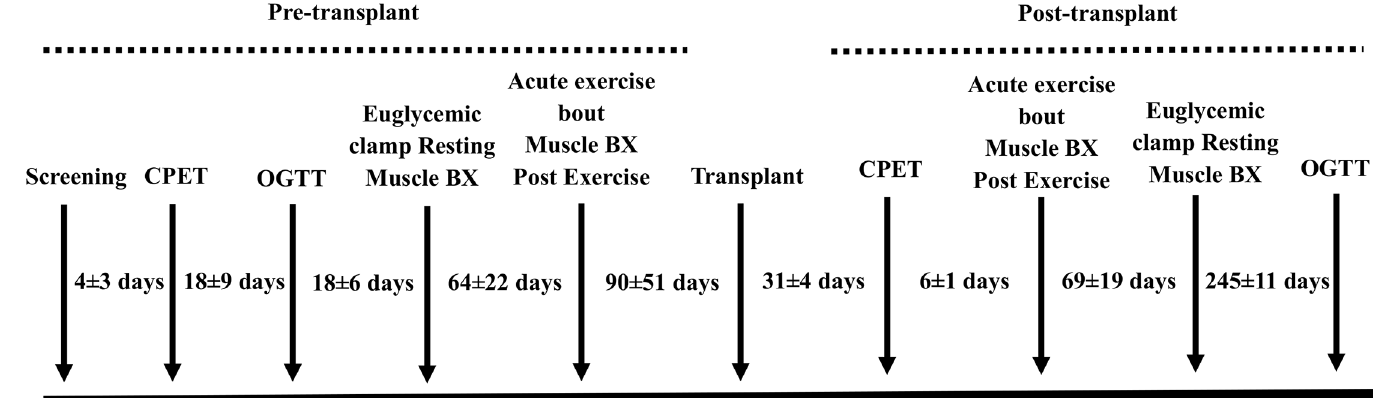
Fig 1. Overall design of